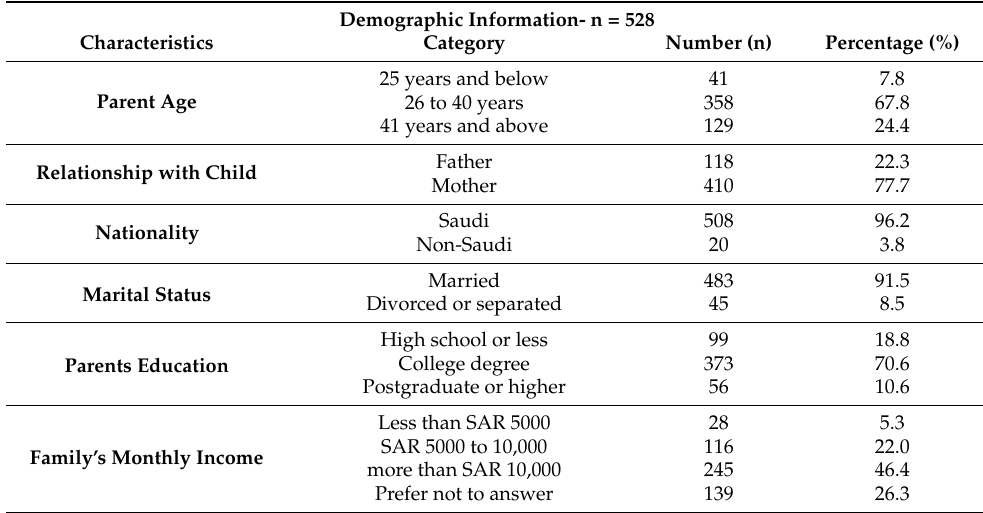
Table 1. Demographic details of the study